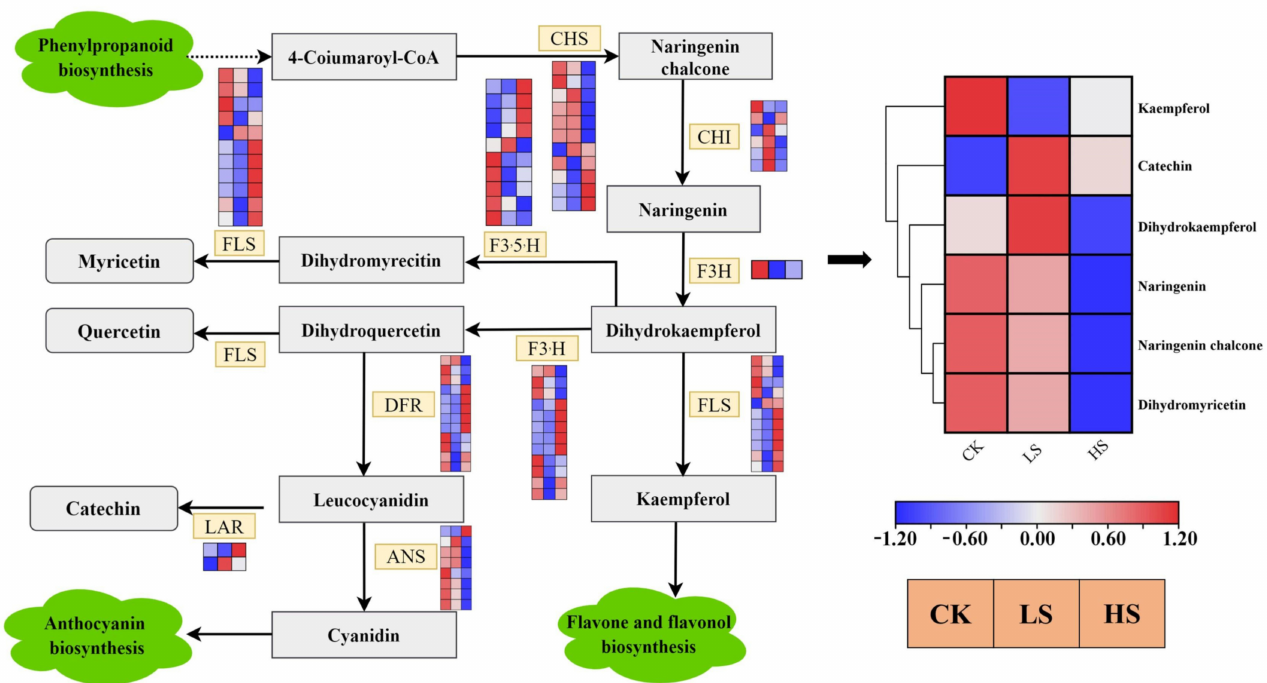
Figure 11. The expression of genes in the flavonoid biosynthetic pathways in the P. koraiensis under light stress. CHS chalcone synthase, CHI chalcone isomerase, F3H flavanone 3-hydroxylase, F3 (cid:48) 5 (cid:48) H flavonoid 3 (cid:48) ,5 (cid:48) -hydroxylase, LAR leucocyanidin reductase, F3 (cid:48) H flavonoid 3 (cid:48) -hydroxylase, FLS flavonol synthase, DFR dihydroflavonol 4-reductase, ANS anthocyanidin synthase. Reconstruction of the flavonoid biosynthetic pathway with the differentially expressed structural genes and the differentially accumulated metabolites (DAMs) in the flavonoid biosynthetic pathway. The cluster marker on the right side of the heatmap represents the names of each metabolite. CK: control. LS: light shade. HS: heavy shade. The color scale from Min (blue) to Max (red) refers to the metabolite contents from low to